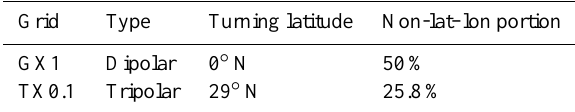
Table 1. Statistics of the sample orthogonal curvilinear